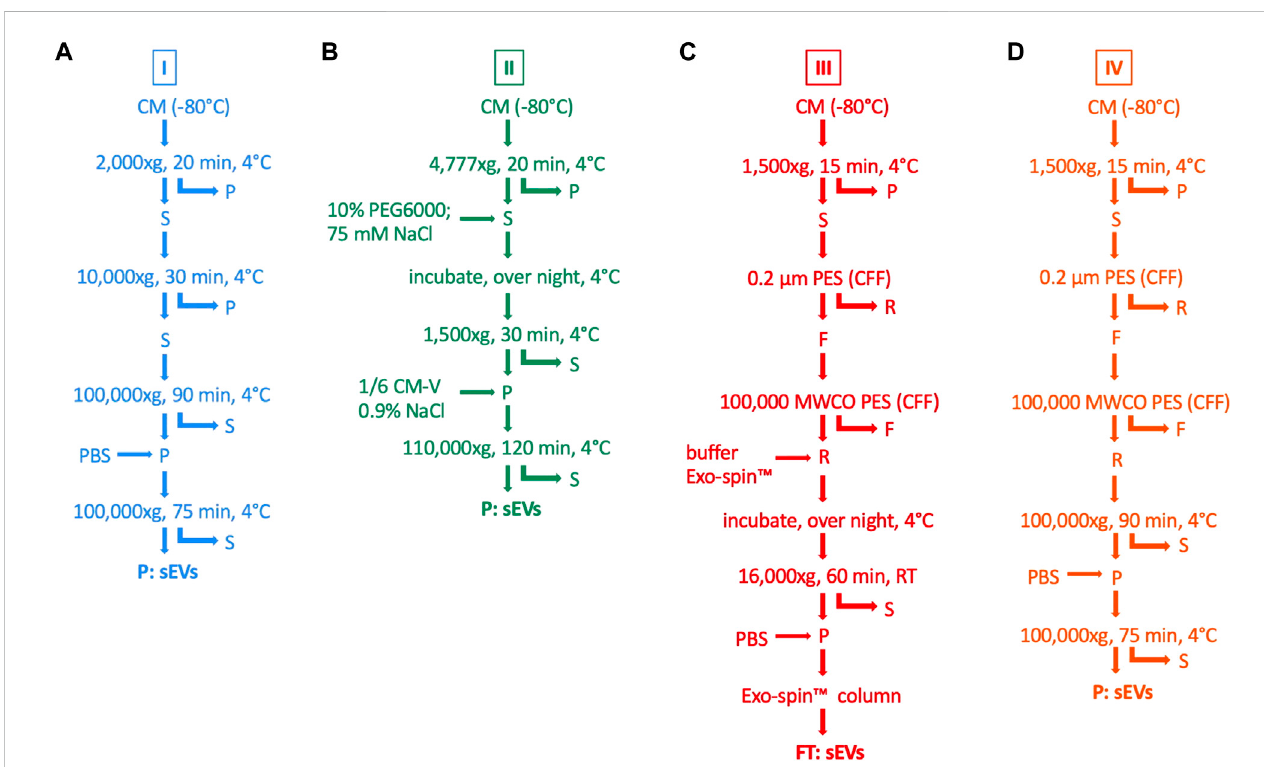
Methods for isolation of sEVs from MSC CM. sEVs were isolated from CM by four different isolation protocols (I — IV). (A) For protocol variant I (blue), CM was centrifuged at 2,000 × g and the pellet (P) was withdrawn. The supernatant (S) was centrifuged at 10,000 × g and the pellet was withdrawn again. These steps were performed for the removal of cellular debris and larger particles. The supernatant was centrifuged at 100,000 × g, the pellet was washed with PBS and centrifuged again in order to fi nally purify sEVs. (B) For protocol variant II (green), cellular debris and larger particles were removed by centrifugation with 4,777 × g followed by mixing the supernatant with 10% PEG6000 and 75 mM NaCl. After incubation overnight at 4 ° C, precipitated sEVs were centrifuged at 1,500 x g and resuspended in 0.9% NaCl, whereby the resuspension volume was de fi ned as one-sixth of the initial volume of CM (CM-V). Finally, sEVs were enriched in the pellet after centrifugation with 110,000 × g. (C) For protocol variant III (red), centrifugation at 1,500 × g and CFF through a polyether sulfone (PES) fi lter membrane with a pore size of 0.2 µm was used for the elimination of cellular debris and larger particles in the pellet and retentate (R). Another CFF through a pore size of 100,000 MWCO was performed, thereby removing smaller particles in the fi ltrate (F) and reducing thevolume for fi nal sEV puri fi cation. The retentate was mixed with Exo-spin ™ buffer, incubated over night at 4 ° C and centrifuged at 16,000 x g. The pellet was resuspended in PBS, and the sEVs were puri fi ed by SEC with Exo-spin ™ columns. (D) For protocol variant IV (orange), steps for the removal of cellular debris and larger particles and volume reduction were the same as for protocol variant III. Finally, sEVs were enriched by UC at 100,000 x g for two times, including one washing step with PBS, as performed in protocol variant